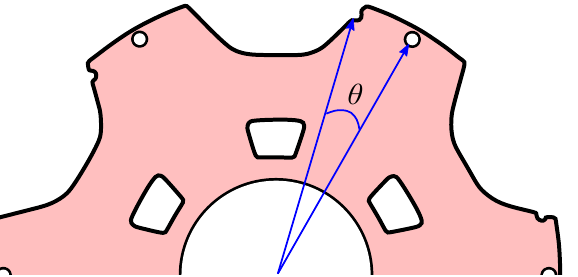
Figure 27. Rotor window and rotor notch on the leading edge of the rotor pole.